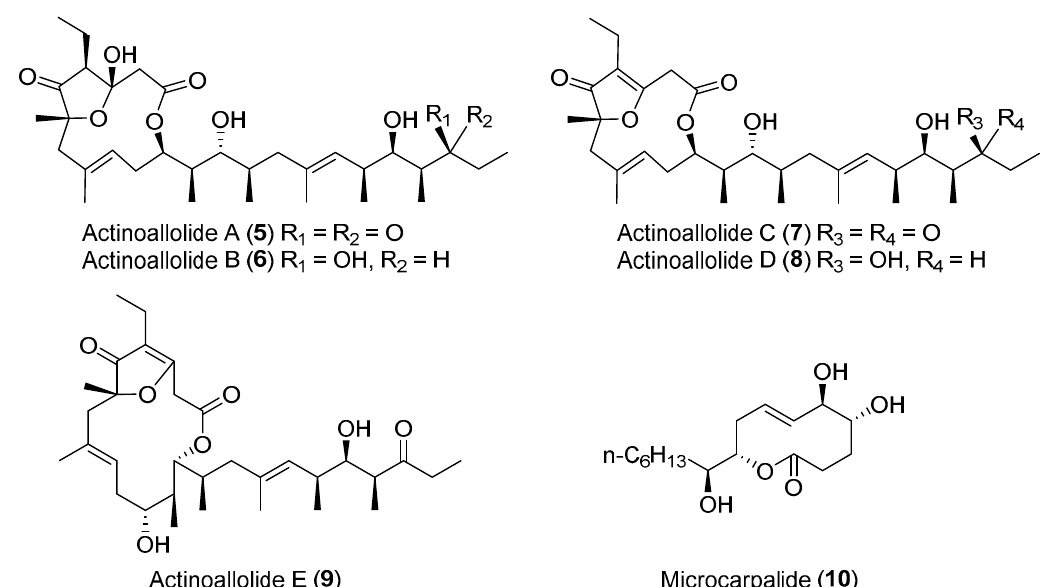
Figure 2. Structures of actinoallolides A–E ( 5 – 9 ) and microcarpalide ( 10 ).